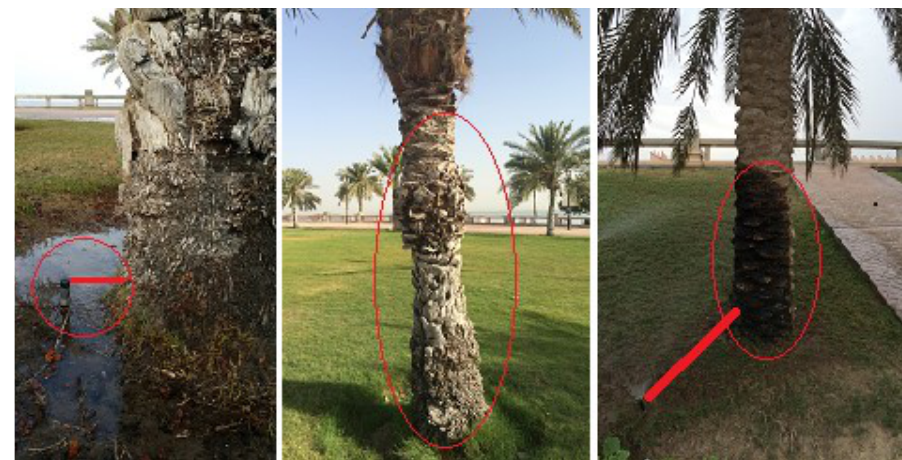
Figure 6: The placement of irrigation dischargers (bubblers 10-30 cm and closer to the palm tree and sprayers are continuously spraying the trunk) cause serious